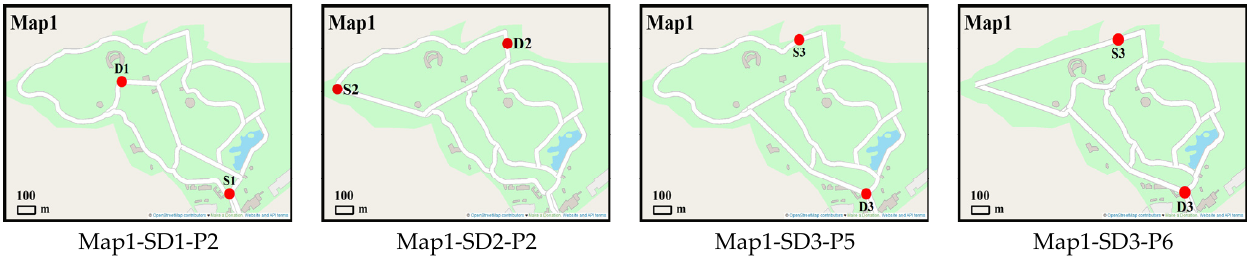
Figure 5. Four modified maps of the recommended routes after shape simplification.